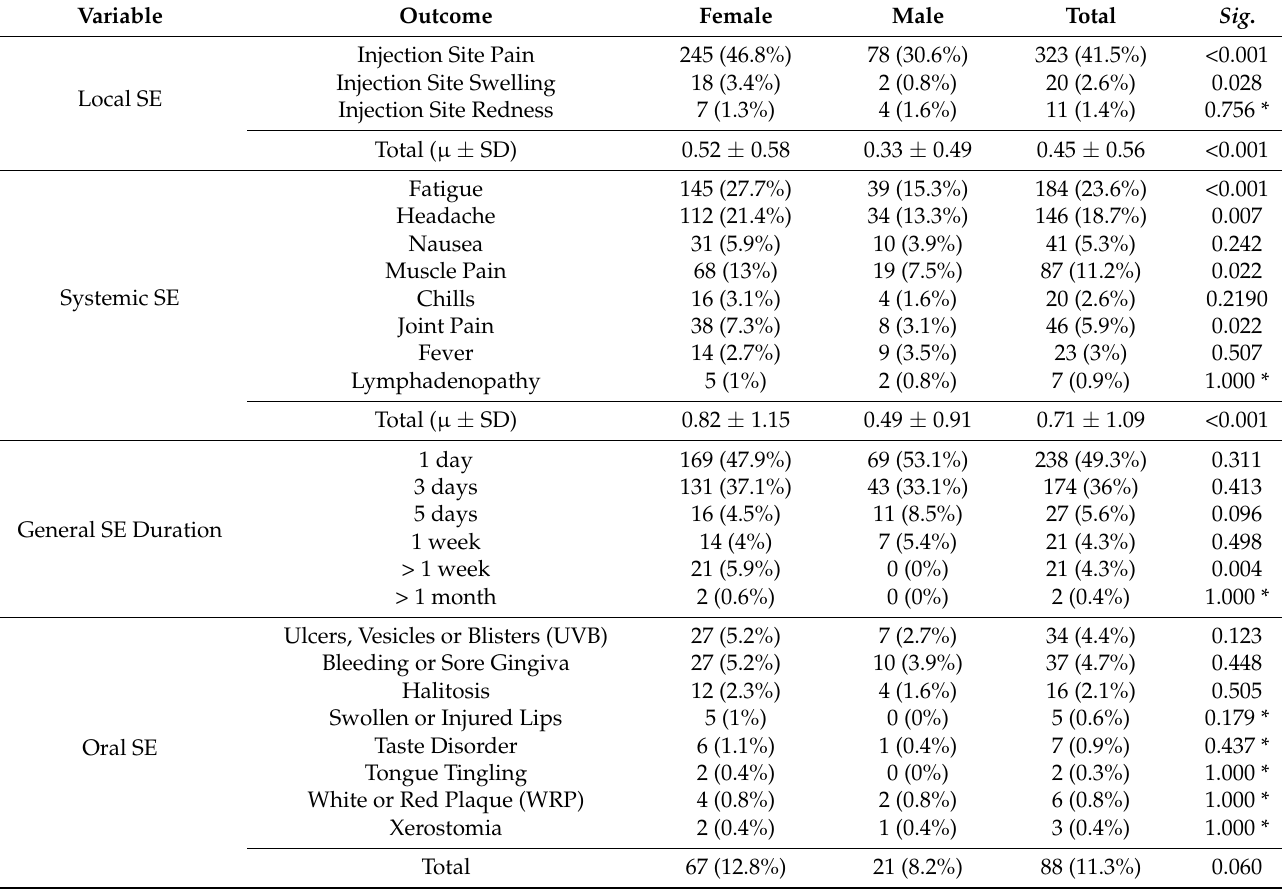
Table 4. Prevalence of CoronaVac side effects reported by Turkish healthcare workers, from January–February 2021.